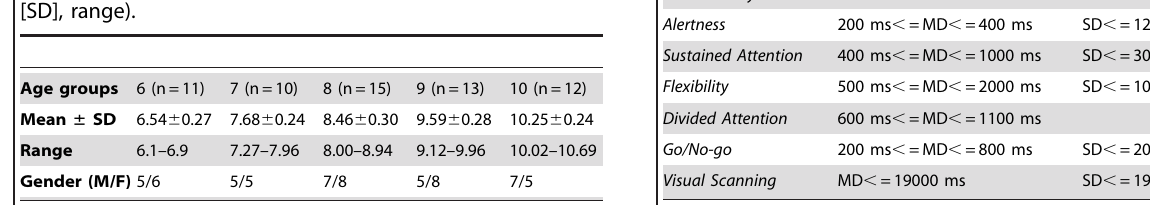
Table 2. Sex and age distribution of the study sample (n=61) as indexed by age groups (yrs., mean + / 2 standard deviation [SD], range).